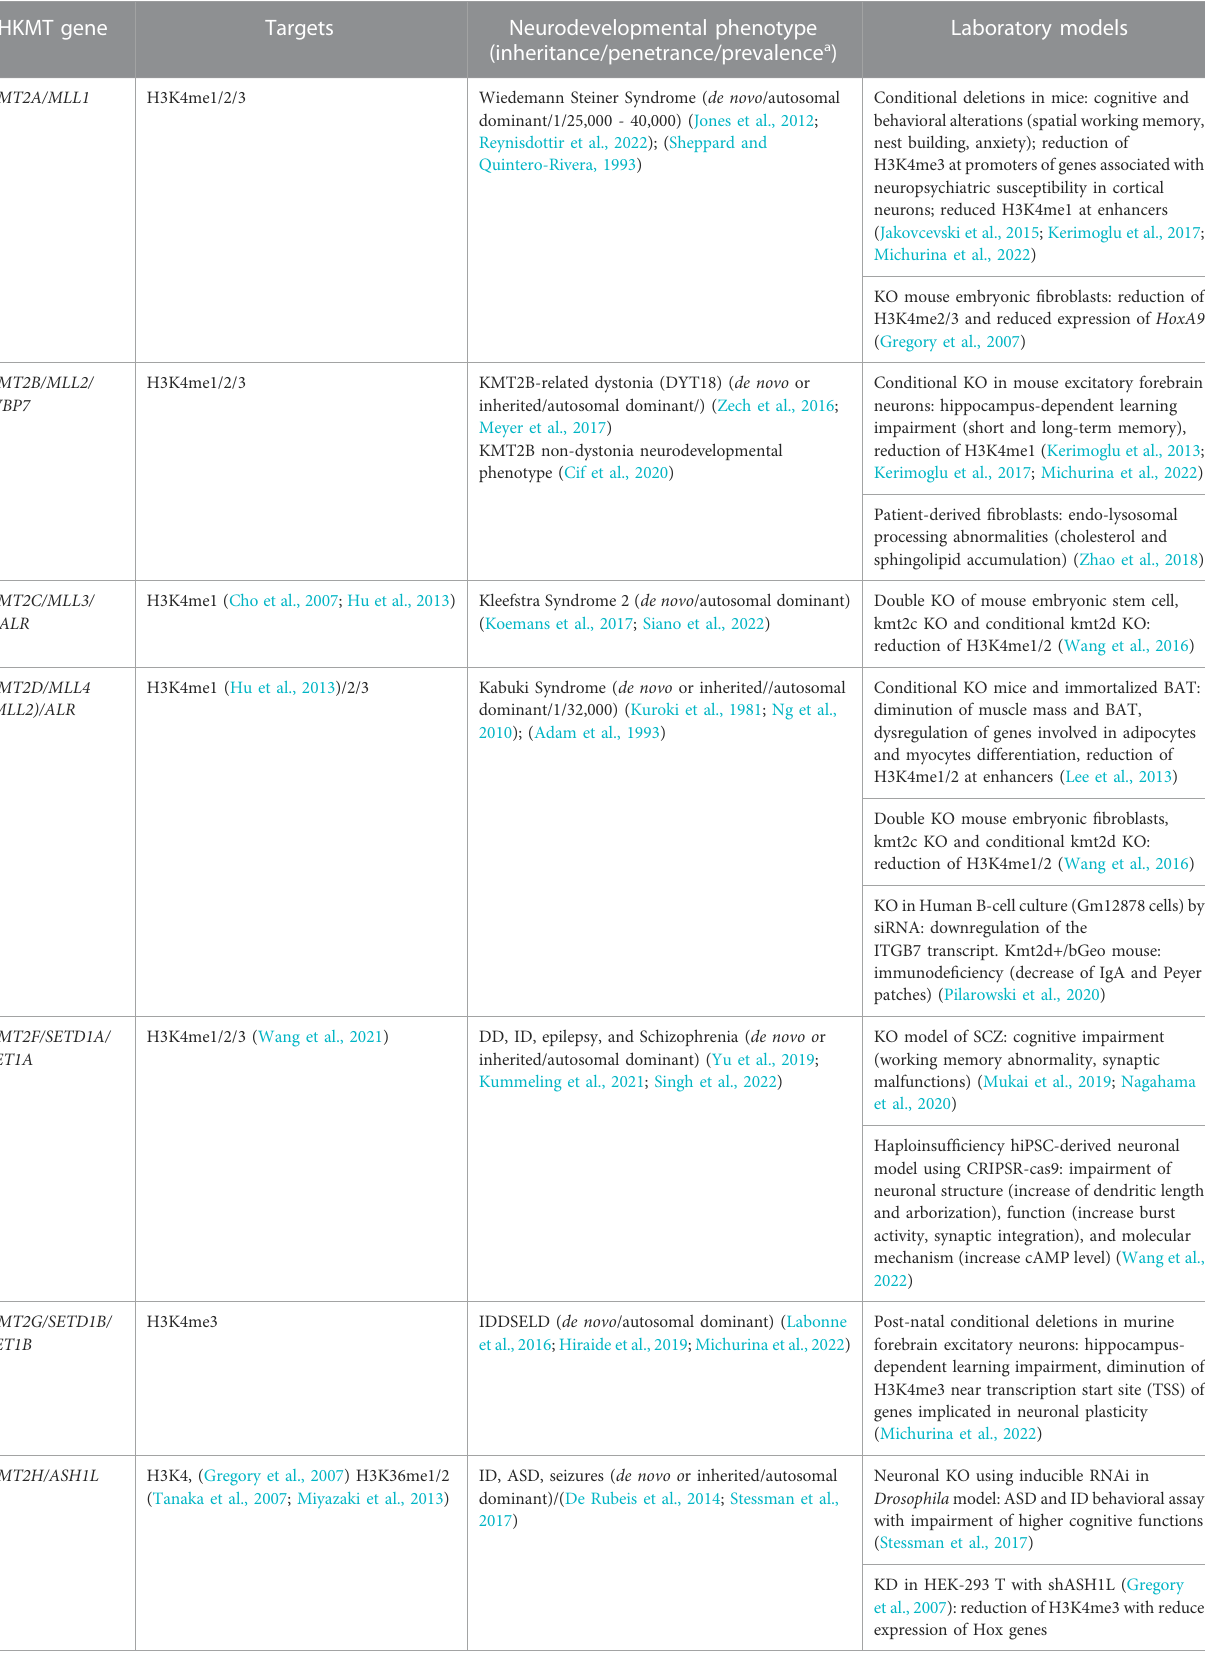
TABLE 1 Histone lysine methyltransferases causing neurodevelopmental disorders and their relevant cell/animal models. HKMT